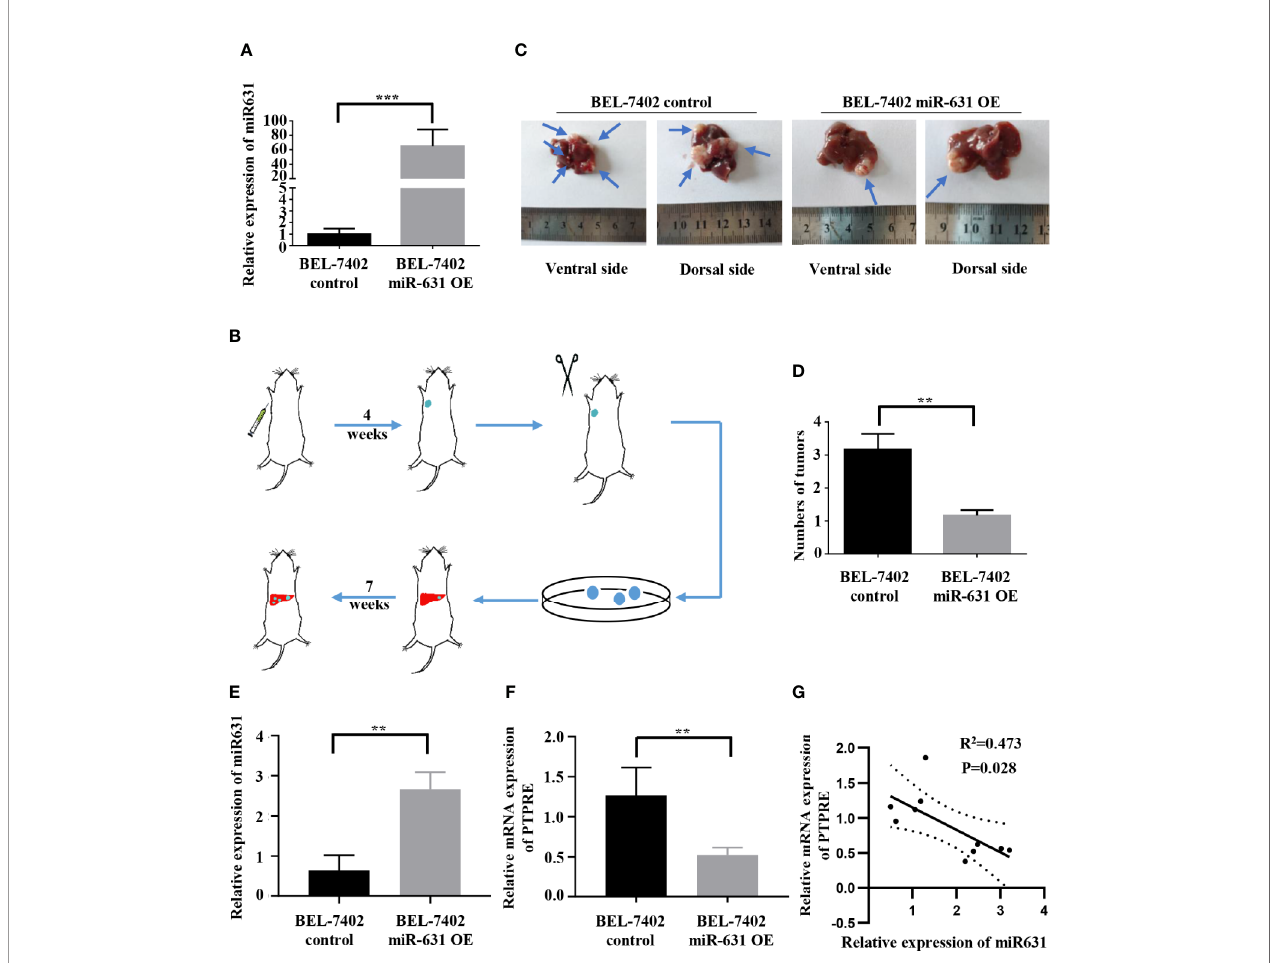
FIGURE 6 | miR-631 inhibits tumor intrahepatic metastasis in vivo . (A) Relative expression of miR-631 detected by qRT-PCR in BEL-7402 control and BEL-7402 miR-631 OE cells which stably overexpressed miR-631 (n = 3). (B) Schematic illustration of in vivo metastasis mouse model. (C) Images of intrahepatic metastasis tumors of BEL-7402 control and BEL-7402 miR-631 OE. (D) The tumor count in livers of BEL-7402 control and BEL-7402 miR-631 OE (n = 6). (E) The relative expression of miR-631 in HCC tissues of mice models. (F) The relative mRNA expression of PTPRE in HCC tissues of mice models. (G) The correlation between miR-631 and mRNA of PTPRE in HCC tissues of mice models. **P < 0.01; ***P <